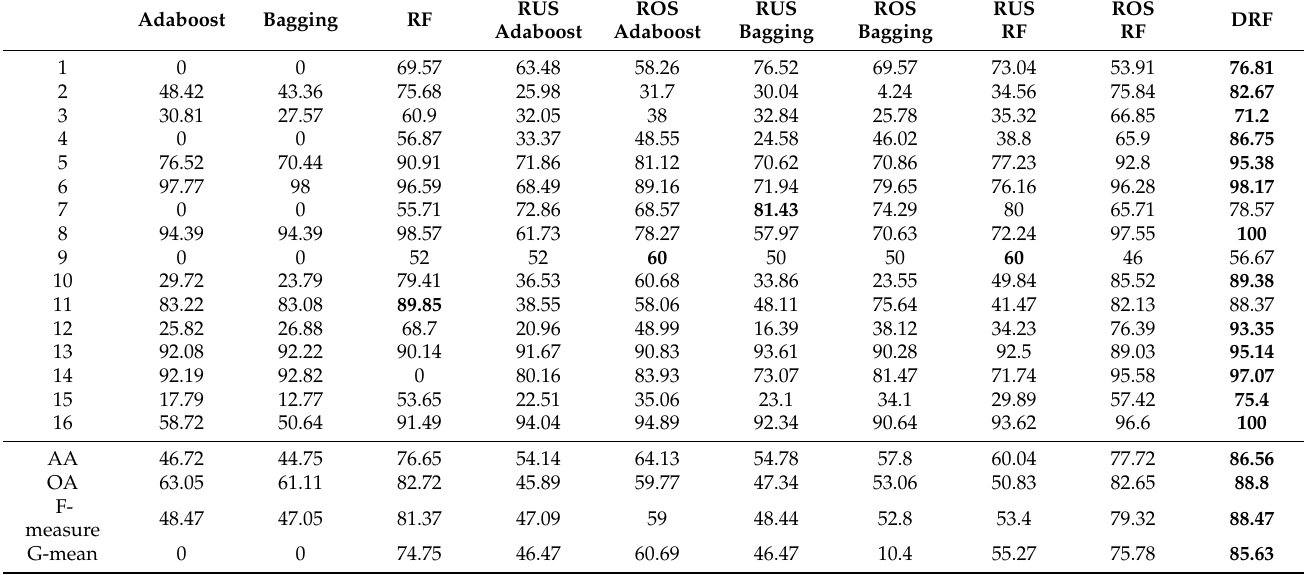
Table 2. Classification results (%) of the Indian image, respectively, obtained by Adaboost, Bagging, RF, RUS + Adaboost, ROS + Adaboost, RUS + Bagging, ROS + Bagging, RUS-RF, ROS-RF, and the proposed